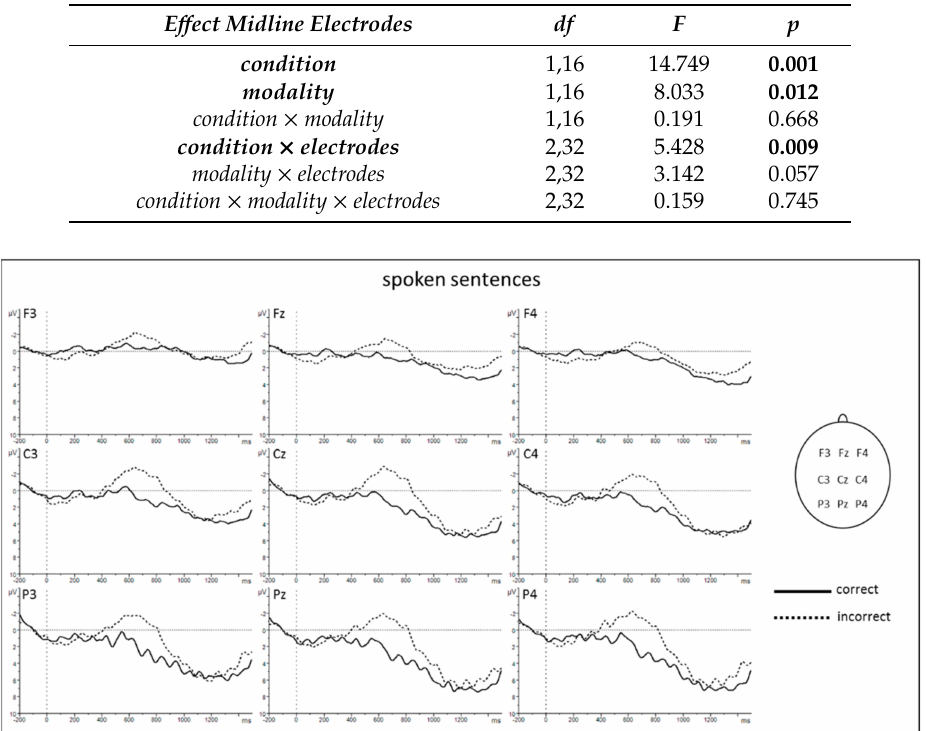
Figure 3. ERP results for spoken sentences. Grand averages from − 200 ms to 1500 ms after verb onset. Negativity is plotted upwards. An 8 Hz low-pass filter was applied for presentation purposes only.